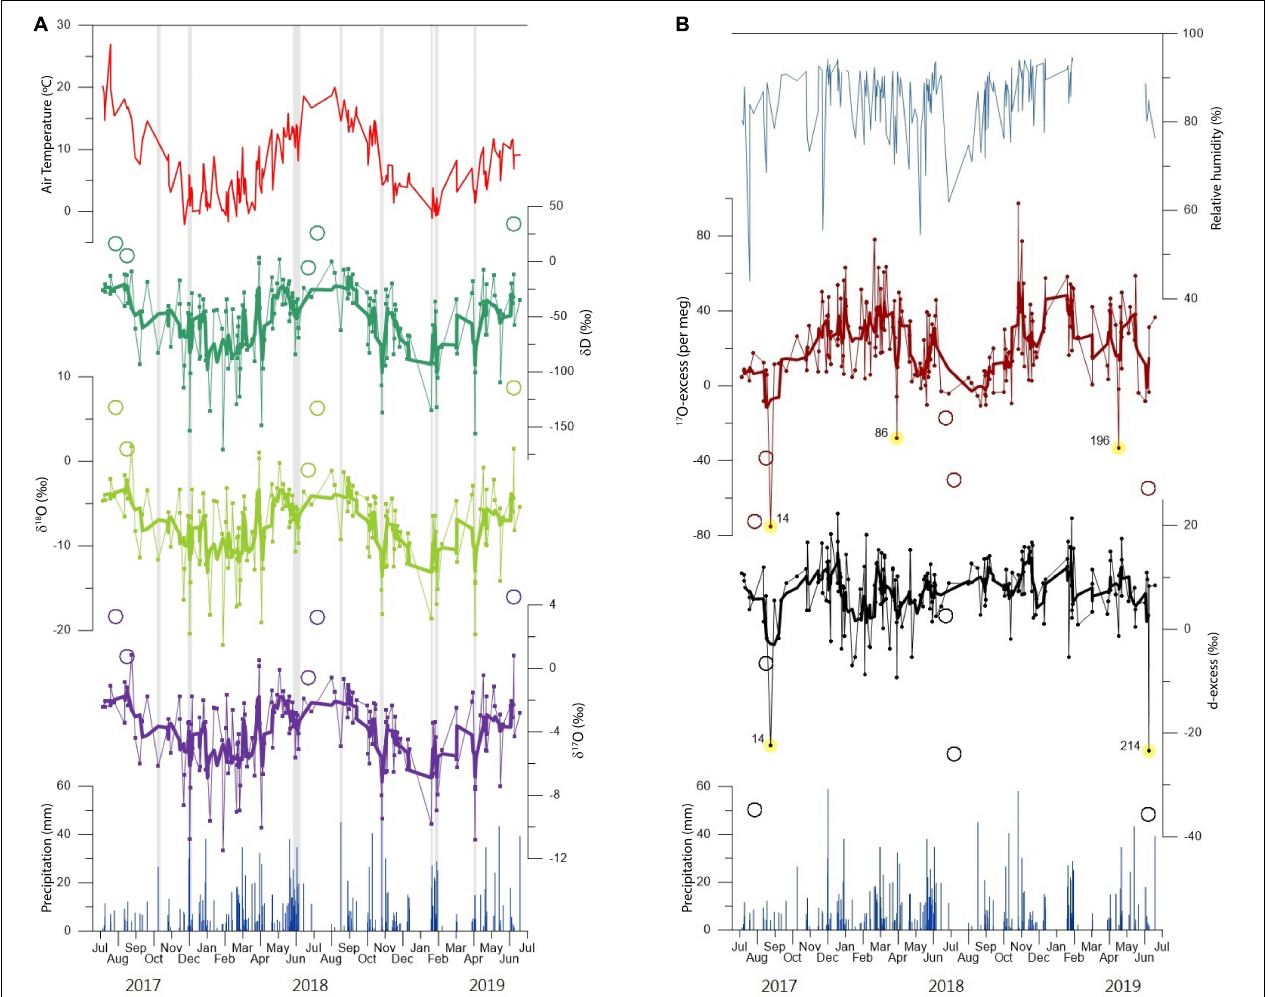
FIGURE 3 | (A) Variation with time of δ 17 O, δ 18 O, and δ D of the precipitation events in Villanúa during the 2-year monitoring period. Dots show precipitation events, and thick lines are produced as five-samples weighted averages. Precipitation amount of each event and event average temperature were calculated from data of Villanúa meteorological station. Shaded areas indicate rainfall events with high precipitation amount and that cause isotope lightening. (B) Deuterium-excess and 17 O-excess series in Villanúa rainfall. The d-excess and 17 O-excess values are represented by dots, and thick lines are produced as 5-samples weighted averages. RH at the precipitation site of each event was obtained from data of Villanúa meteorological station. Yellow shaded circles indicate d-excess and 17 O-excess outliers without evidence of evaporation due to sampling that have been considered for calculations. For both graphs, unfilled circles correspond to rainfall waters that underwent evaporation prior to sampling and were not considered for the calculations of the weighted